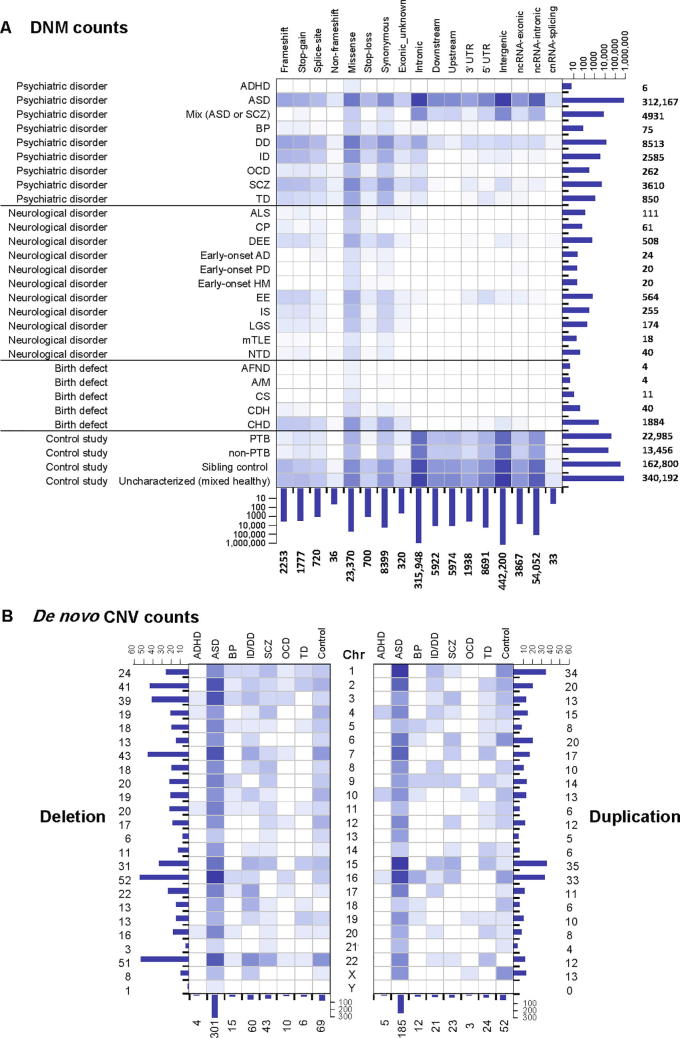
Statistics of the DNVs collected by PsyMuKBA. The heatmap shows the statistics of DNMs currently in PsyMuKB. The DNMs are divided into four different clinical phenotypes (in rows): psychiatric disorder, neurological disorder, birth defect disorder, and control study. The functional categories of DNMs are separated into 17 different types (in columns), by impacted coding regions (frameshift, stop-gain, spliced-site, non-frameshift, missense, stop-loss, synonymous, and exonic unknown), to the non-coding areas (intronic, downstream, upstream, 5′-UTR, 3′-UTR, intergenic, and ncRNA). B. The heatmap shows the statistics of de novo CNVs currently in PsyMuKB. CNVs are collected from nine different clinical phenotypes, including ADHD, ASD, and SCZ (in columns). The figure is separated into two panels. The left represents deletion events in CNVs, and the right panel represents the duplication events in CNVs. The color in the heatmap represents the counts of each phenotype for a particular variation type with the darker the color, the higher the count. ALS, amyotrophic lateral sclerosis; CP, cerebral palsy; DEE, developmental and epileptic encephalopathies; HM, high myopia; IS, infantile spasms; LGS, Lennox Gastaut syndrome; mTLE, mesial temporal lobe epilepsy; NTD, neural tube defect; AFND, acromelic frontonasal dysostosis; A/M, anophthalmia and microphthalmia; CS, Cantu syndrome; CDH, congenital diaphragmatic hernia; PTB, fetal preterm birth.